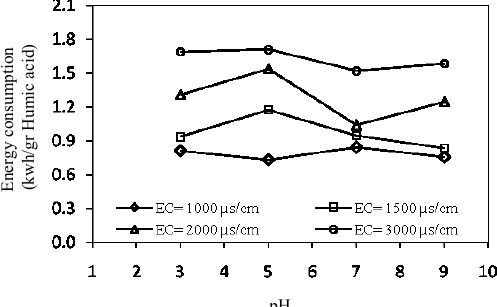
Figure 5. Variation of energy consumption as a function of initial pH and conductivity (initial concentration of HA: 20 mg L -1 , applied voltage: 50 V and reaction time: 75